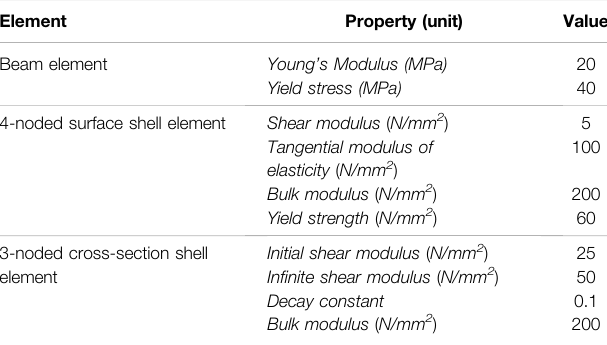
TABLE 3 | Material properties of beam elements in the MF model (Green and Long, 2014) and shell elements in the 3DShell model (El Said et al., 2014; LSTC. LS-DYNA,